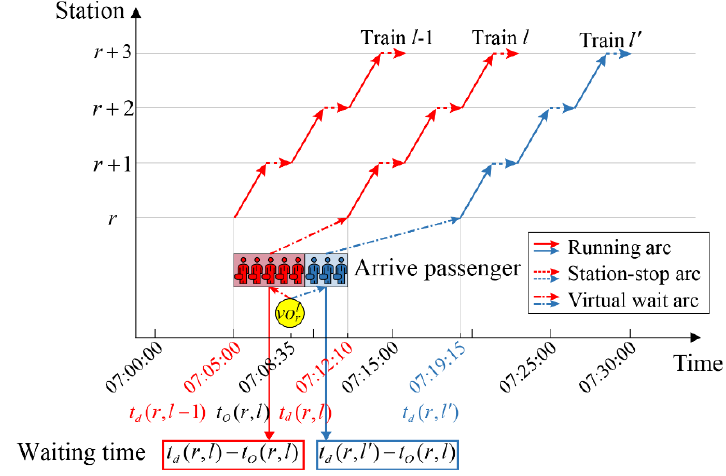
Figure 4. An illustration of passenger waiting time.